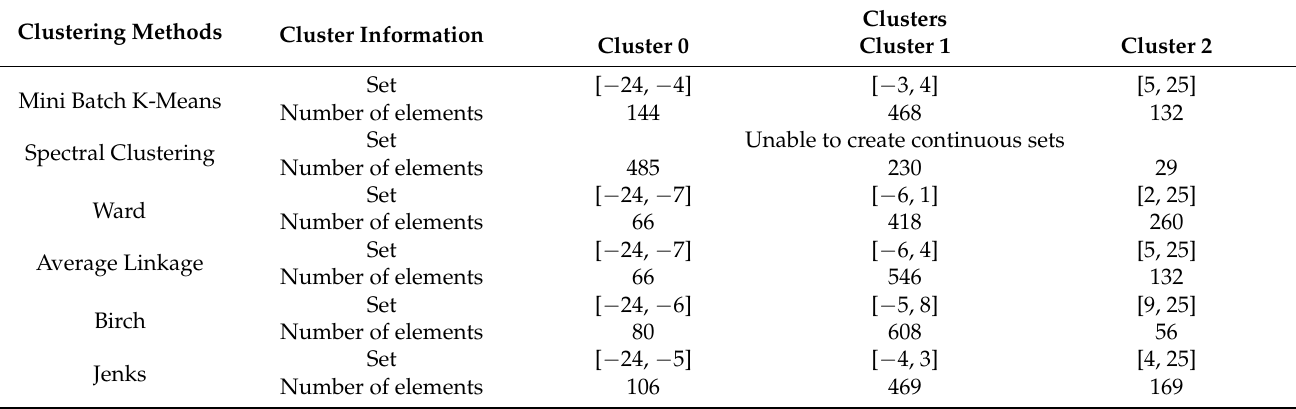
Table 8. Clustering results.